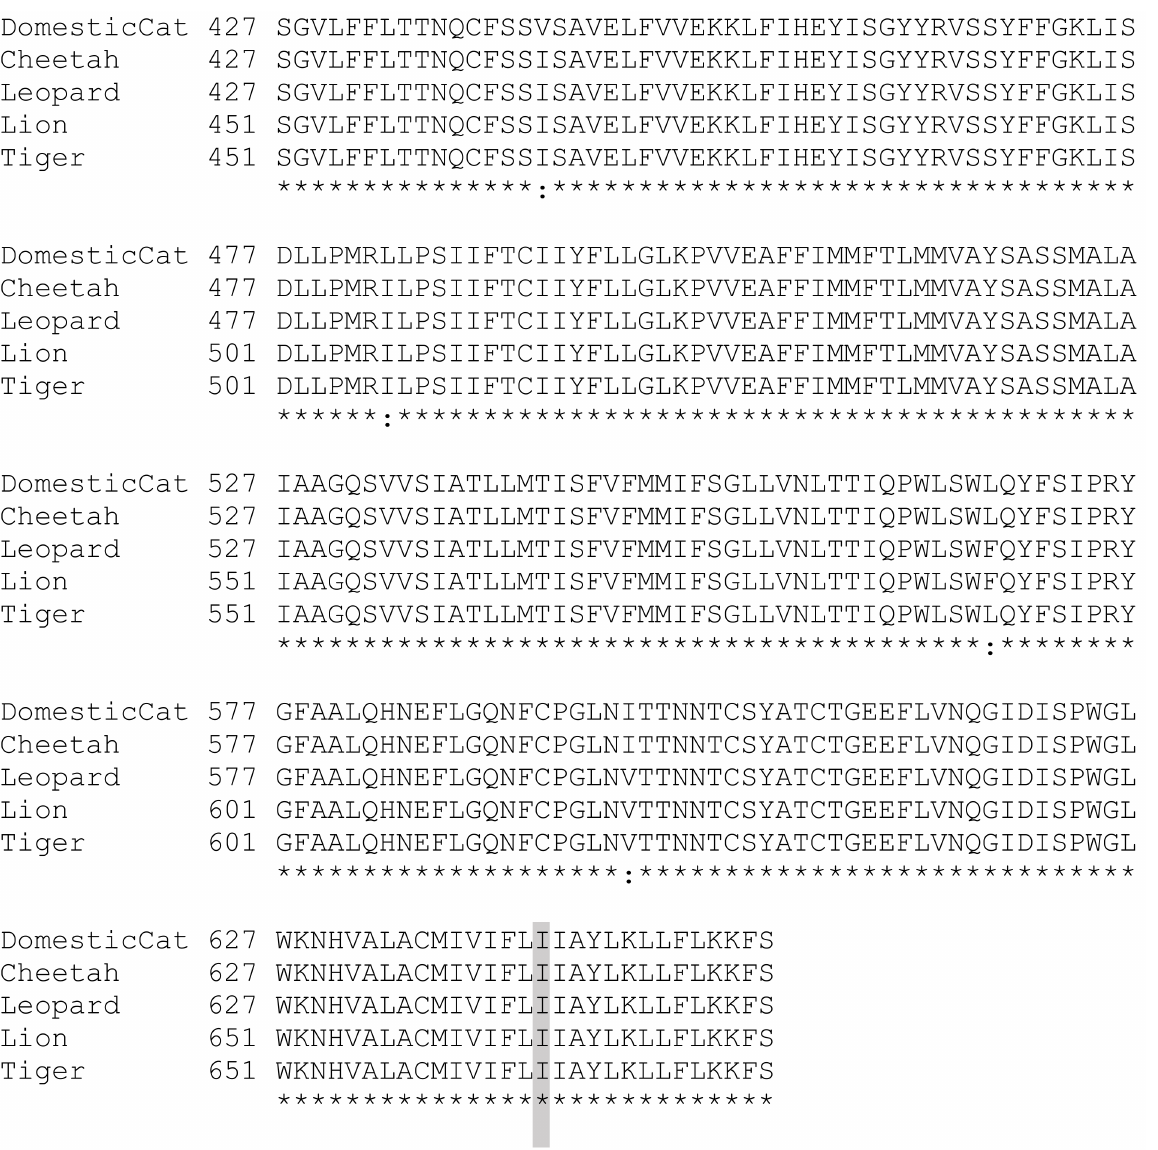
Figure A1. ABCG2 amino acid alignment for domestic cat, cheetah, leopard, lion, and tiger. * All data were accessed on 21 September 2022 via NCBI. Genome assembly builds accessed are FelCat9.0 (domestic cat, XP_023108715.2), Aci_jub_2 (cheetah, XP_026916402.1), PanPar1.0 (leop- ard, XP_019320292.1), P.leo_Ple1_pat1.1 (lion, XP_042791867.1), and P.tigris_Pti1_mat1.1 (tiger, XP_042840143.1). The four domestic cat missense amino acid changes studied in this paper are highlighted in